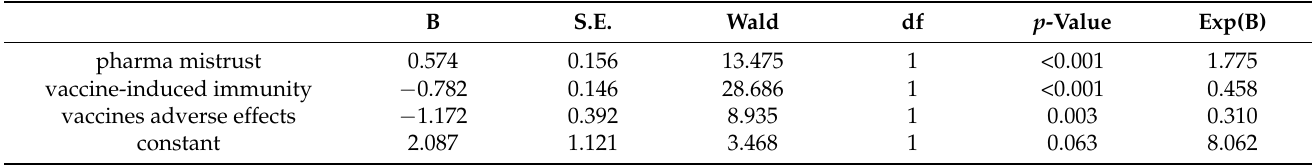
Table 2. Variables in